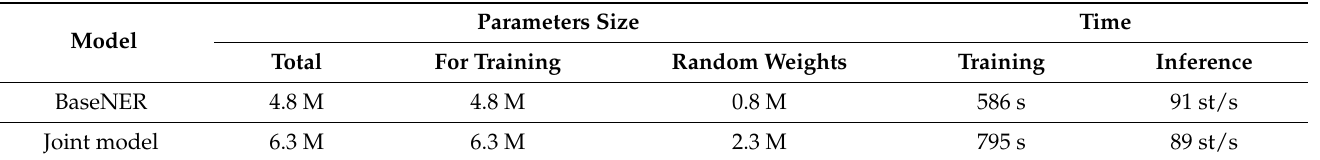
Table 8. Network comparison. Note M is short for million, s is short for second, st/s is the inference speed, which is the number of sentences inferred per